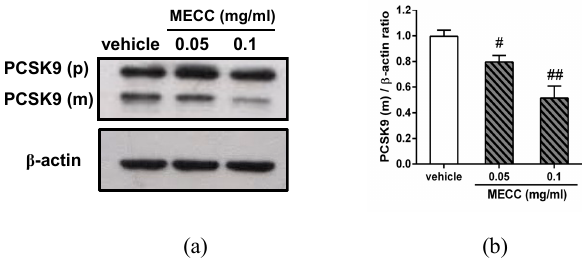
Figure 5. Effects of MECC on PCSK9 protein expression in HepG2 cells. Cells were cultured in LPDS medium and treated with vehicle (0.1% DMSO) or MECC (0.05 and 0.1 mg/mL) for 24 h. ( a ) The PCSK9 proprotein form (p), mature form (m) and β -actin proteins were determined by Western blot analysis. The experiments were at least replicated three times, and a representative blot was shown. ( b ) The intensity of the PCSK9 mature form protein (PCSK9 (m)) normalized to the β -actin is presented as the means ± SD of three independent experiments. # p < 0.05 and ## p < 0.01 represent significant differences compared to the vehicle-treated group.